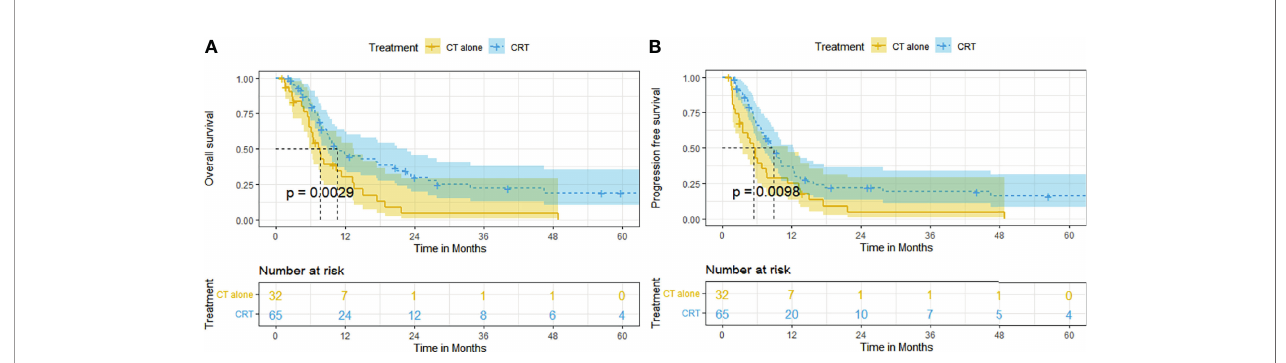
FIGURE 3 | Kaplan – Meier curves of survival in patients with locally advanced ESCC treated with CRT and CT: (A) overall survival; (B) progression-free